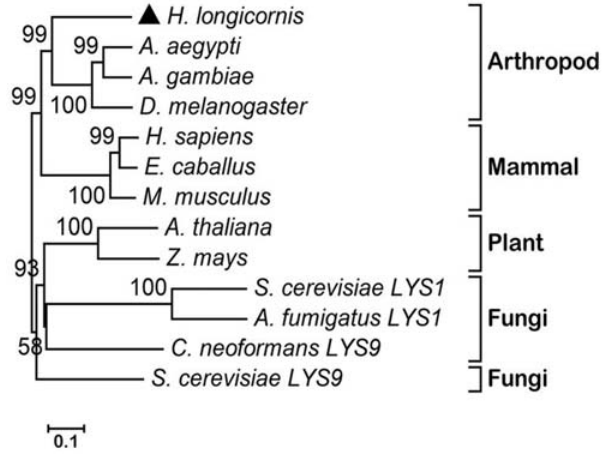
Figure 1. Phylogenetic tree of the protein sequences of LKR/ SDH genes. The LKR/SDH amino acid sequences used were downloaded from GenBank and aligned in MEGA4 with CLUSTALW and the plylogenetic tree made by MEGA version 4.0 based on the neighbor-joining method. Values with 1,000 replications. The sequences used were A. gambiae (XP314728), Aedes aegypti (XP001649464), D. melanogaster (AAF52559), H. sapiens (CAA07619), M. musculus (CAA12114), Equus caballus (XP001502225), Arabidopsis thaliana (AAB53975), Zea mays (AAG21985), Saccharomyces cerevisiae LYS9 (CAA96331) (LYS9-L-glutamate forming), Cryptococcus neoformans (LYS9-L-glutamate forming) (AAW40810), S. cerevisiae LYS1 (CAA86194), (LYS1-L-lysine forming), and Aspergillus fumigatus LYS1P (XP754450) (LYS1-L-lysine forming).